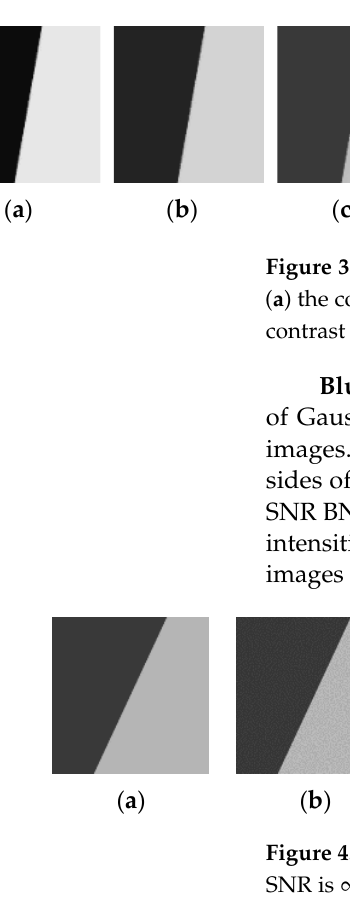
Figure 2. Partial simulated BDE image with different angles (0~45 deg): ( a ) when edge angle is 0 deg, ( b ) when edge angle is 5 deg, ( c ) when edge angle is 15 deg, ( d ) when edge angle is 25 deg, ( e ) when edge angle is 35 deg, ( f ) when edge angle is 45 deg. simulated partial BDE@Con images with different contrasts are shown in Figure 3.